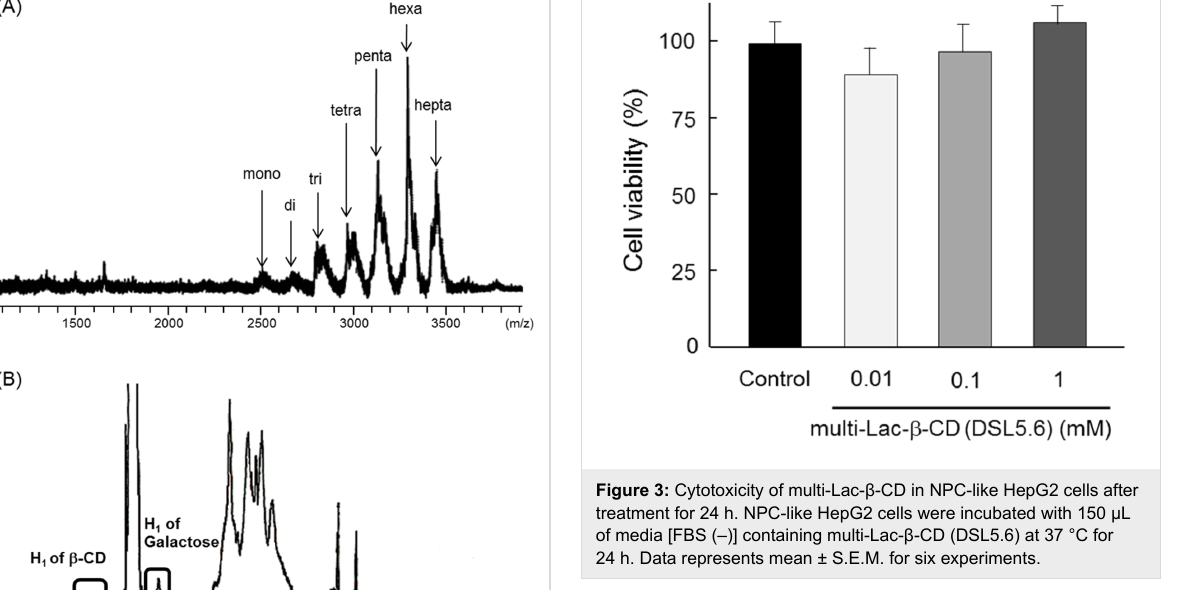
served to be lower than that of TRITC-multi-Lac- β -CD (DSL5.6) (Figure 5B). In summary, these results indicate that multi-Lac- β -CD (DSL5.6) was distributed to the endolyso- somes after cellular uptake by the NPC-like HepG2